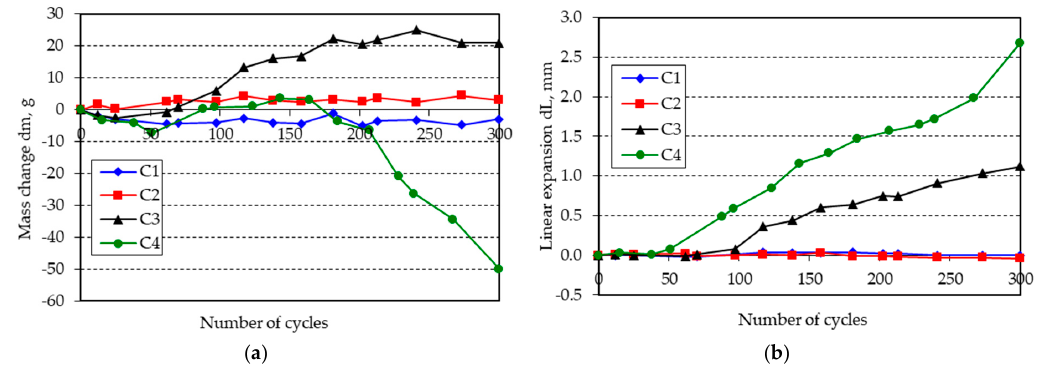
Figure 3. ( a ) Mass change; ( b ) linear expansion of specimens C1–C4 following freezing and thawing in water.